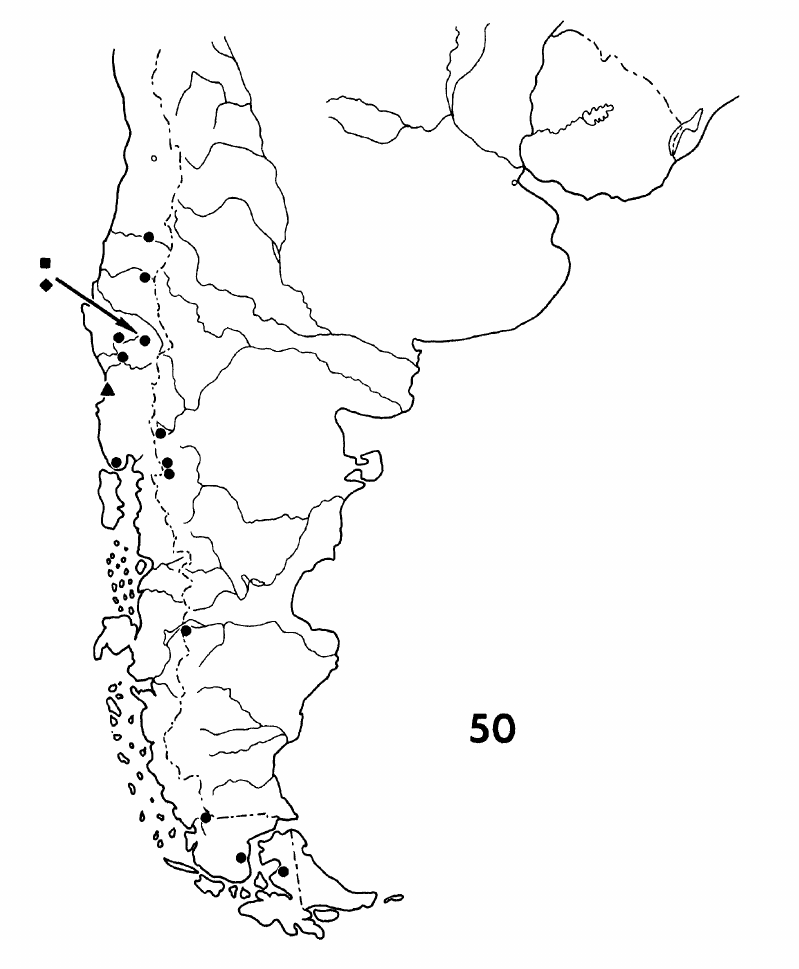
Fig. 50. Southern Chile and Argentina, showing locality records for South American Glypholoma spp.: G. pustuliferum, dots; G. temporale, diamond; G. pecki, square; G. tenuicorne,